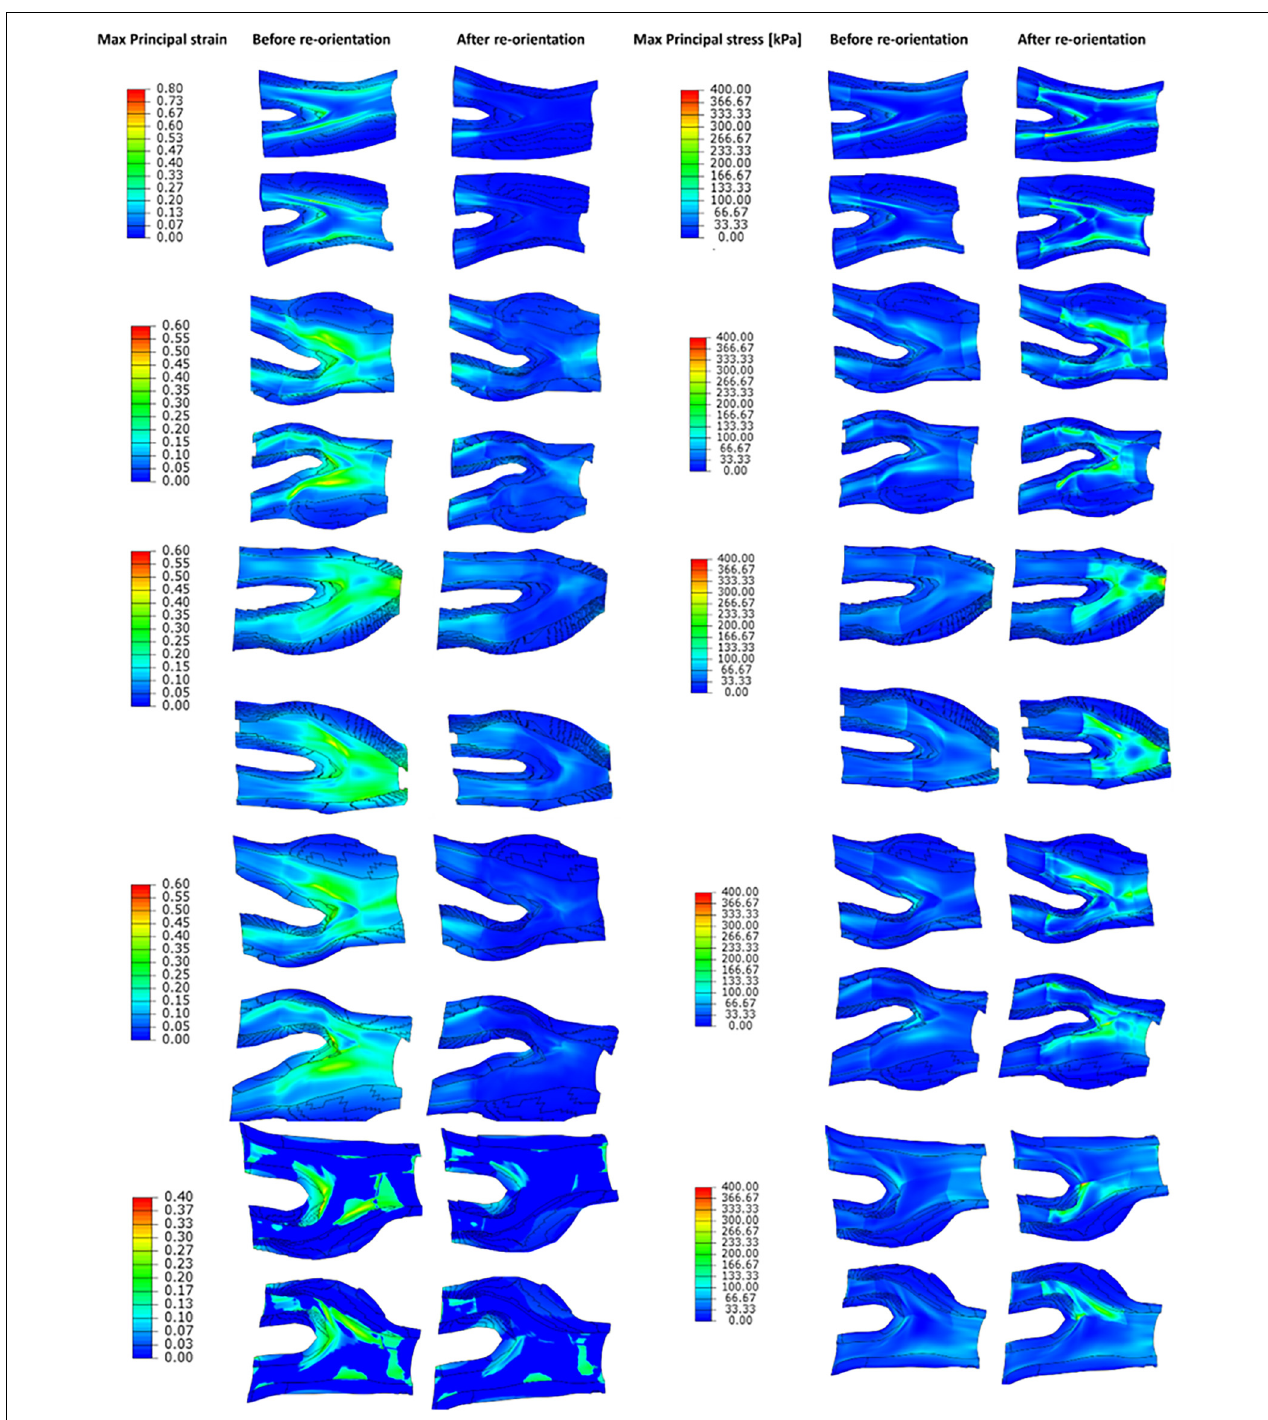
FIGURE 10 | The contour plots of maximum principal strain and stress values obtained before and after remodelling of collagen fibres in the diseased